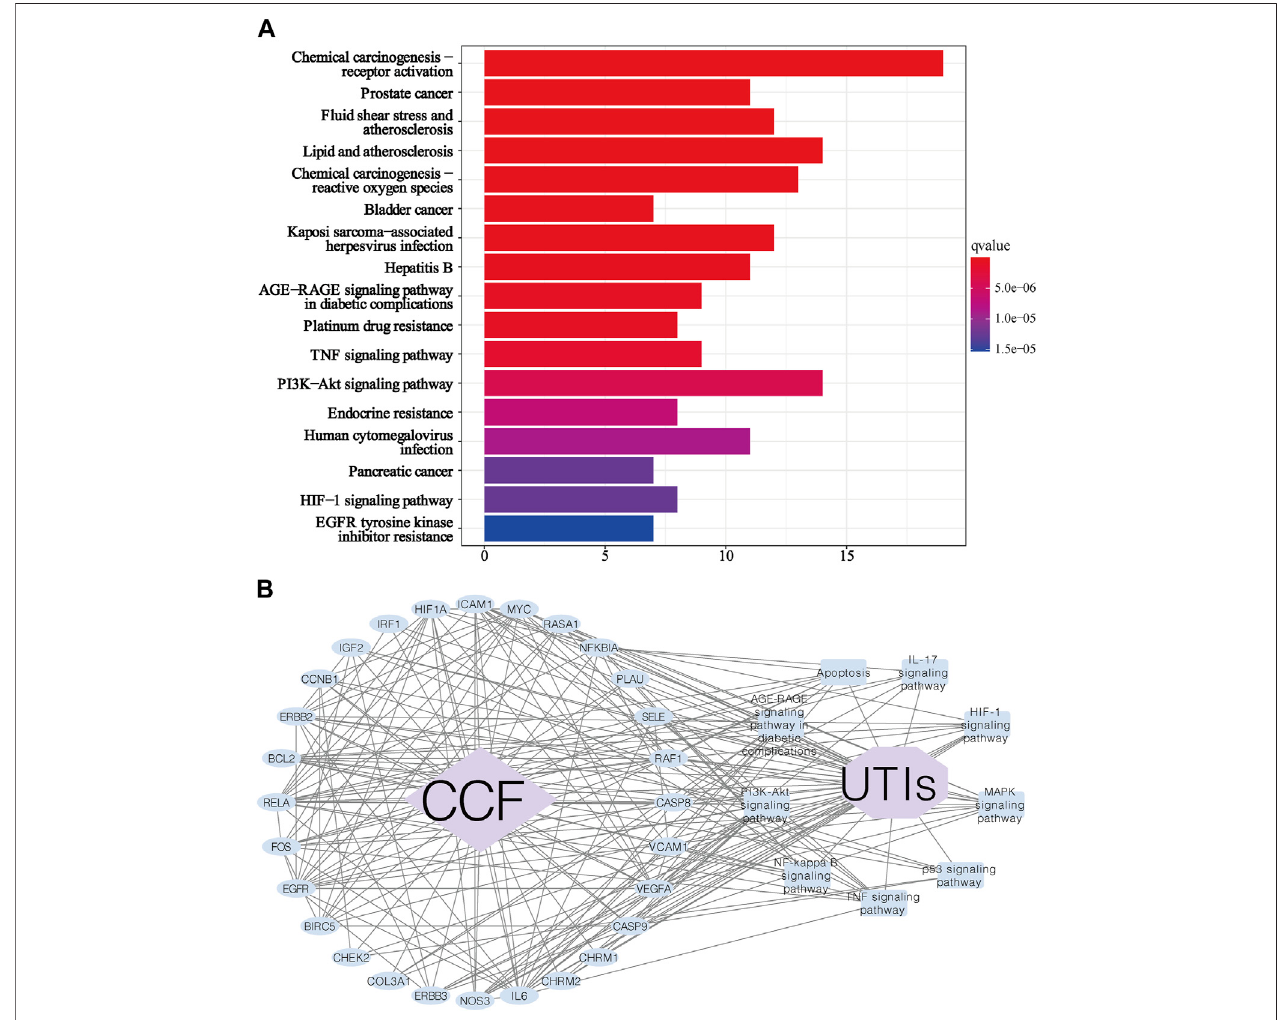
FIGURE 7 | KEGGenrichmentanalysisfortheidenti fi edgenes. (A) EnrichmentanalysisoftheKEGGsignalpathwayforthepotentialtargetsinthetreatmentofUTIs.Eachbar representsaKEGGtermonthe y -axis,whilethehorizontalaxisindicatesthenumberofproteinsenrichedineachterm.Thecolorshowstheadjusted p -valueofeachKEGGterm.The bluerthecoloroftheterm,thesmallerthepadjustedvalue.( B) Target-signalingpathwaynetwork;theblueellipsenodesrefertothetargets,theblueroundrectanglesshowthepicked biological functions or signaling pathways, the purple octagon means the disease, the purple diamond indicates the drug, and the black lines represent the interaction.